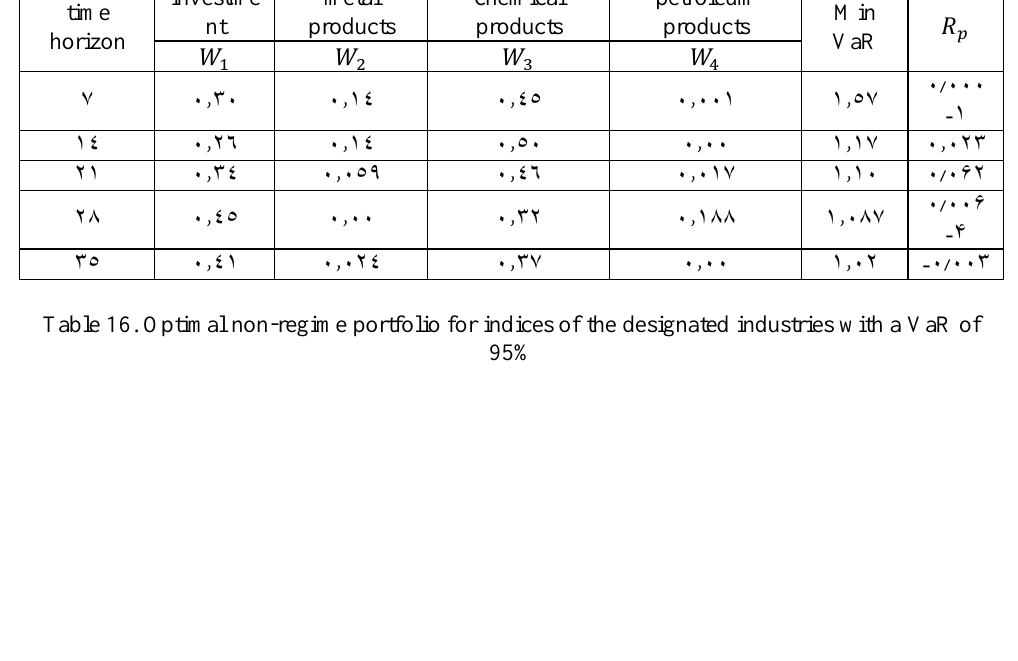
petroleum products